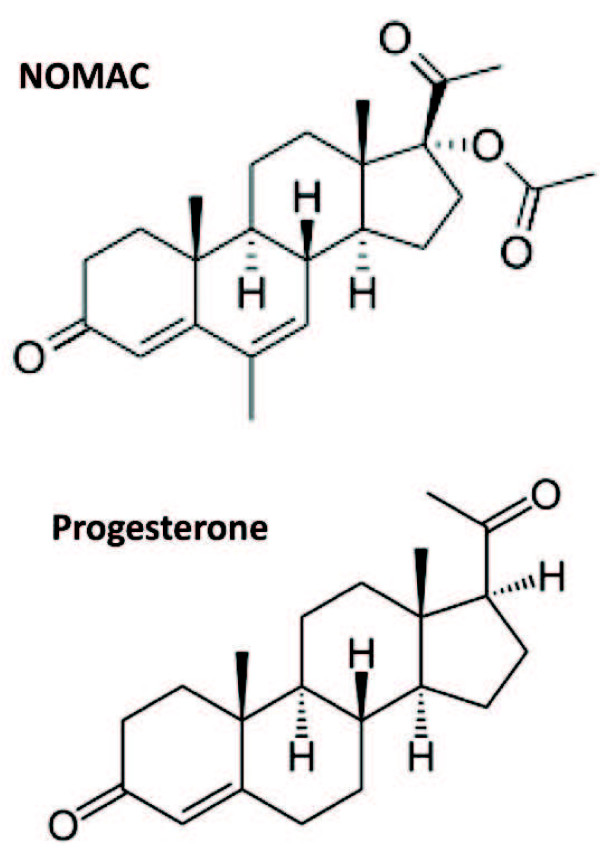
Structures of progesterone [[2]] and NOMAC [[3]].